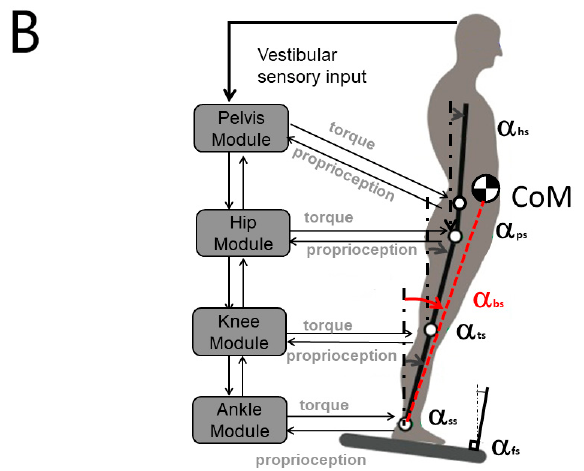
Figure 3. ( A ) Schematic model of disturbance estimation and compensation (DEC) control module. The subsystem labeled “Controlled system” represents the mechanics of the body; ( B ) network of interconnected DEC control modules. The symbol α represents the angle in space of the upper body ( α us ), pelvis ( α ps ), body center of mass ( α bs ), thigh ( α ts ), shank ( α ss ) and of the foot support base ( α fs ). Each module controls the CoM of all body segments above the indicated joint (example: body center of mass, CoM, above ankle joints).